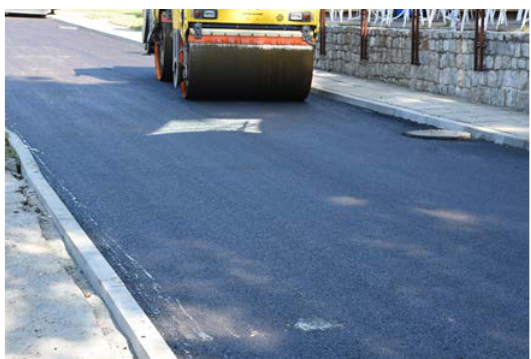
Figure 9. Milled surface of the binder course.